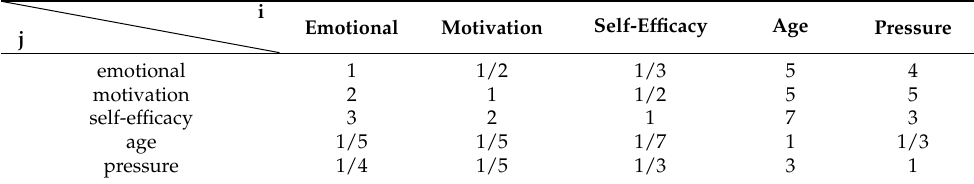
Table 3. Judgment matrix of factor layer indicators of the features of the trainees.